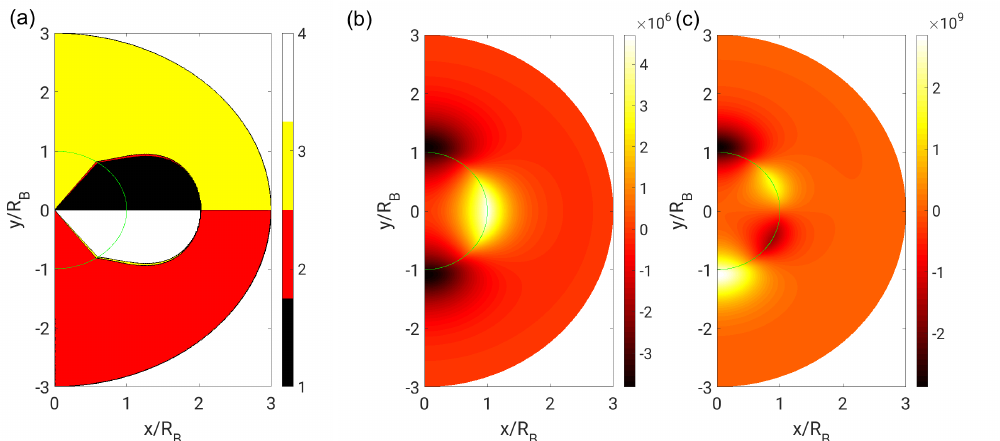
Figure 9. ( a ) Flow topologies; ( b ) second invariant Q ; and ( c ) third invariant R in the neutral case ( ξ = 1) with near-field boundary conditions ( r W = 3 r B ).